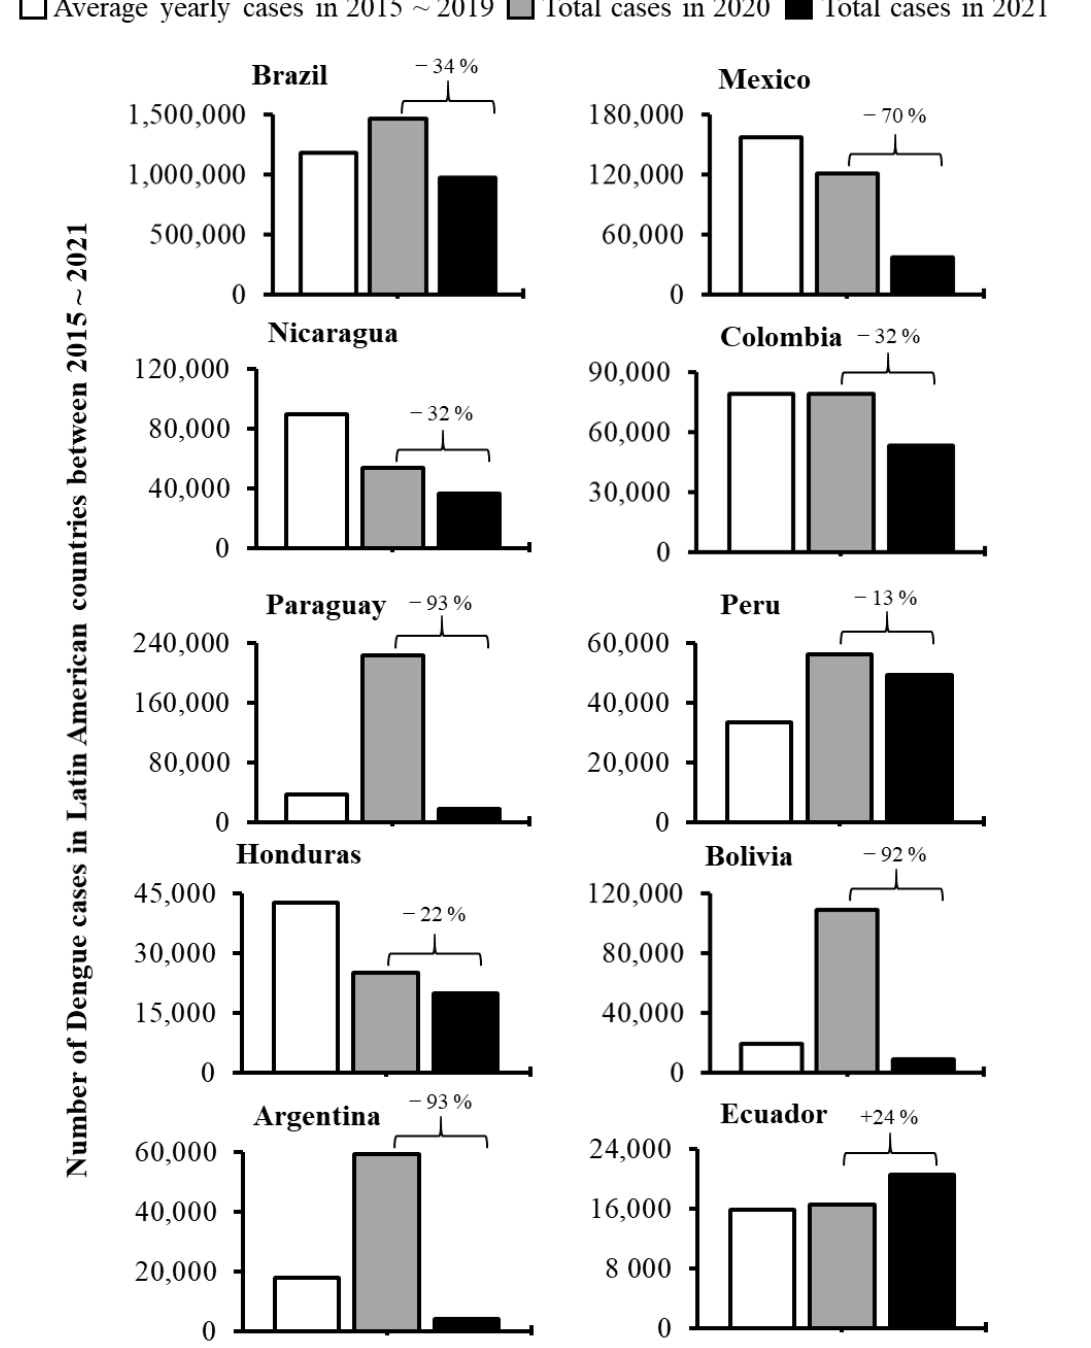
Figure 2. Comparison of dengue incidences in major dengue epidemic countries of Latin America between the pre-COVID-19 time (2015~2019) and COVID-19 period (2020~2021).